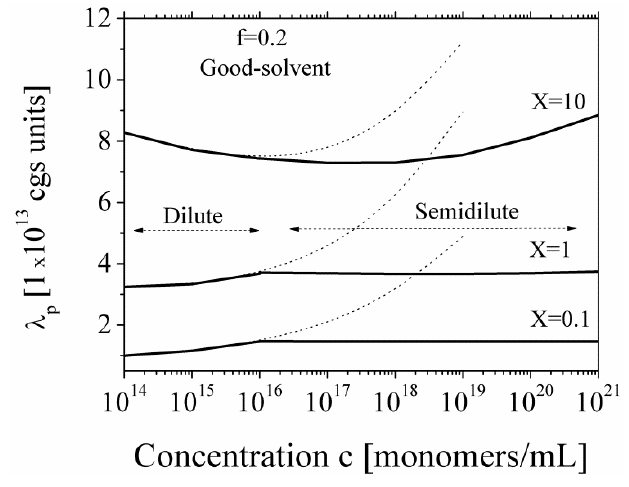
of polyions in good solvent regime, for dilute Figure 6. The equivalent conductance λ p and semidilute conditions, calculated according to Equations (5.2.1) and (5.2.2) in the presence of added salt, for three different values of the parameter X . Dotted lines show the calculated values in the dilute region extrapolated to semidilute region. The parameters s u = 0.137 cgs l = 7 × 10 − 8 cm; b = 2.52 × 10 − 8 cm; η = 1 cP; are: N = 2250; B 1